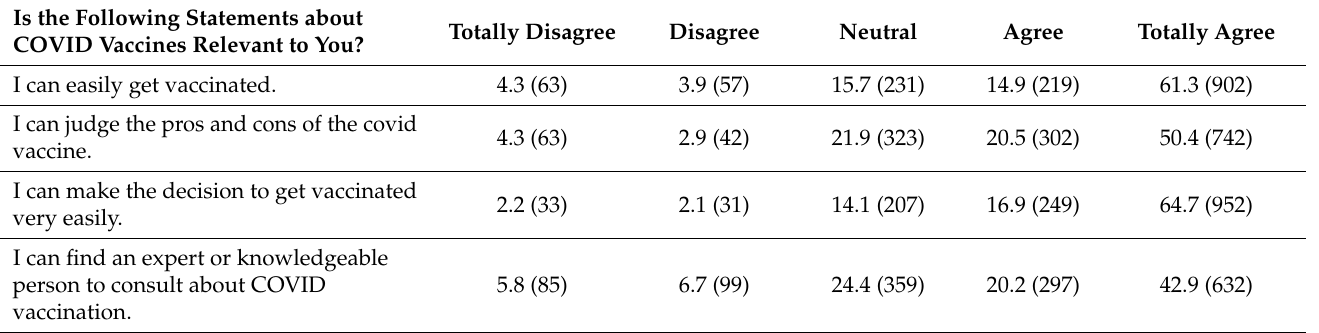
Table 5. Participants’ self-efficacy ( n =